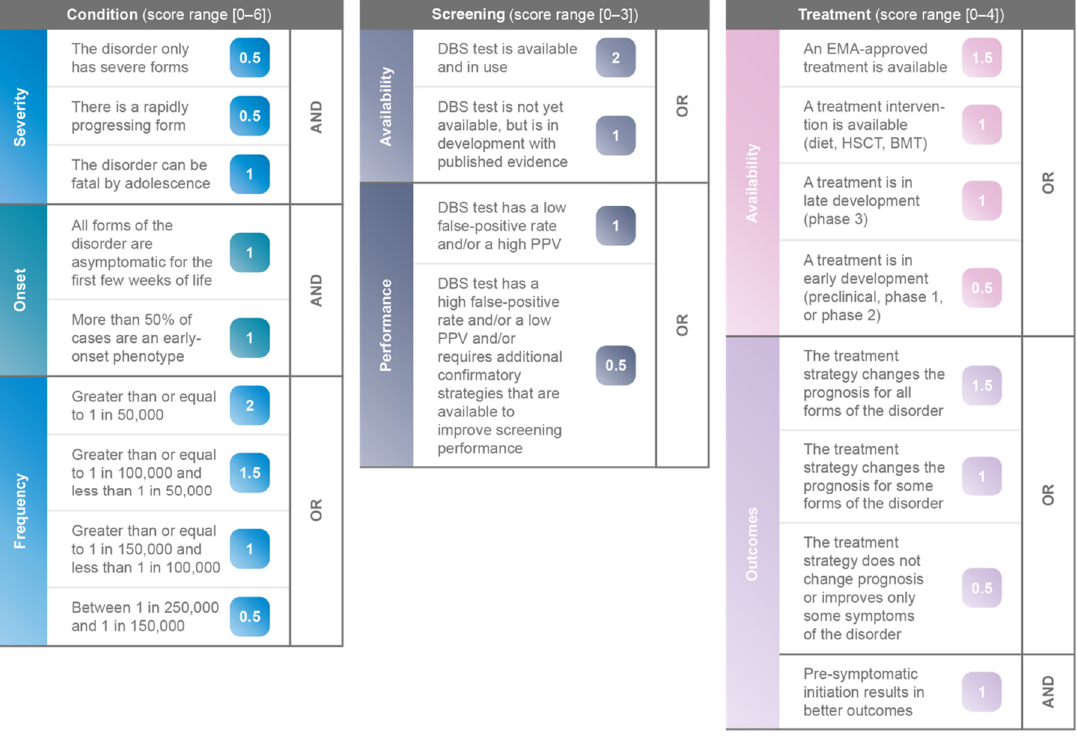
Figure 1. Selection of disorders for analysis [8–10,13,14].